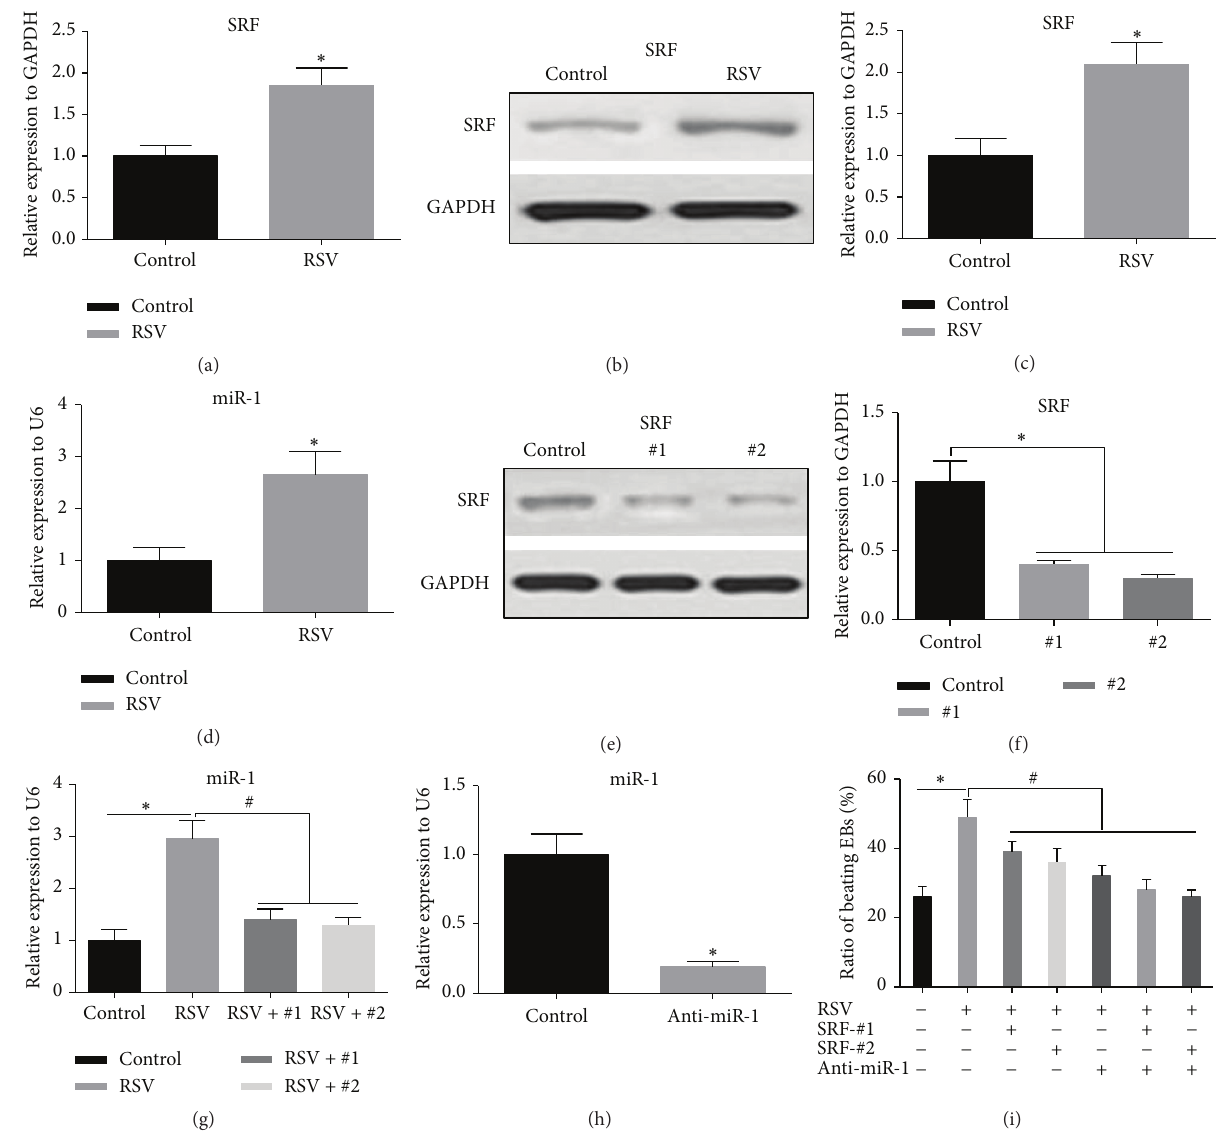
Figure 4: Serum response factor- (SRF-) miRNA-1 axis also involves the CMs differentiation enhanced by RSV. (a) Transcription levels of SRF in cultured EBs treated with RSV (50 𝜇 M) were detected by qRT-PCR on day 4. (b, c) Western Blot was further carried out to determine the protein levels of RSV (50 𝜇 M) treated EBs after 4 days. (d) miRNA-1 expression level was also detected using qRT-PCR 4 days after RSV (50 𝜇 M) administration. (e, f) Knockdown of SRF using produced Lentivirus expressing shRNA targeting SRF was confirmed by Western Blot analysis. (g) SRF-miRNA-1 signal axis was confirmed in EBs treated with RSV (50 𝜇 M) on day 4. (h) Inhibition of endogenous miRNA-1 in floating cultured EBs 4 days after transfection of Lentivirus within anti-miRNA-1. (i) The effects of modulation of SRF or/and miRNA-1 on the ratio of beating EBs were evaluated on day 24 ( 𝑛 = 100 ). Data represent the mean ± s.d. of three biological replicates. ∗ 𝑃 < 0.05 compared with control; # 𝑃 < 0.05 compared with RSV